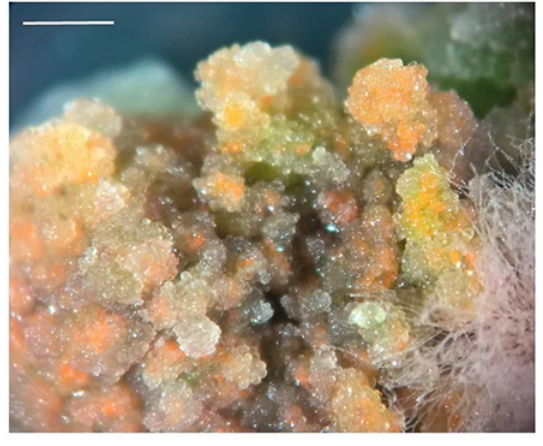
Figure 22 Chelidonium majus rhizogenic callus tissue cultured on Murashige and Skoog (MS) solid medium supplemented with 1.0 μM kinetin, 0.5 μM 1-naphthyloacetic acid (NAA), and 2.5 μM 2,4-dichlorophenoxyacetic acid (2.4-D) under photosynthetic active radiation (PAR) LED light; scale: 1